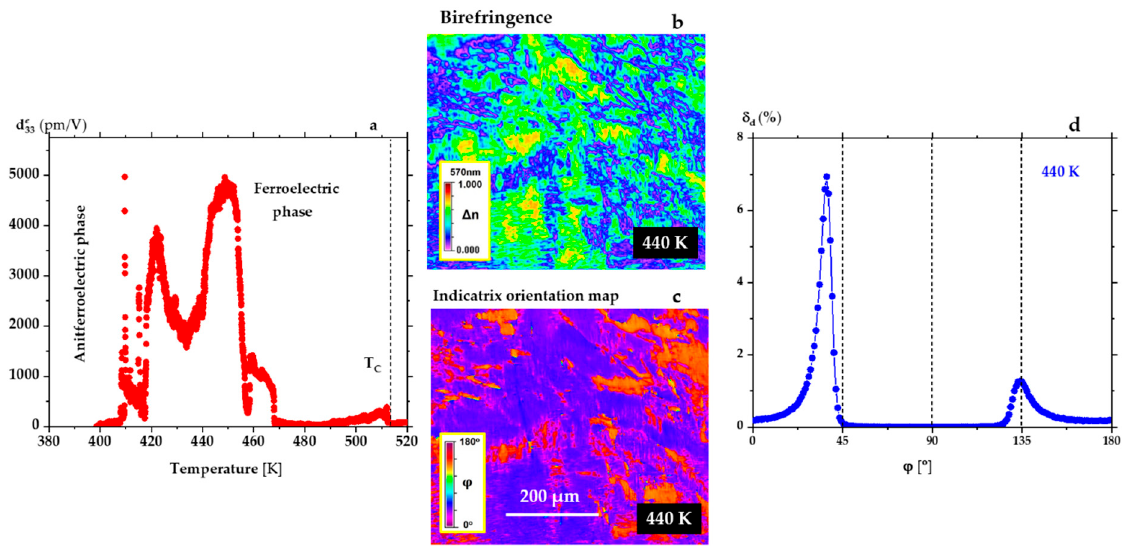
Figure 4. ( a ) Giant piezoelectric effect recorded on heating, in the temperature range between the AFE-FE and FE-P phase transitions in a PbZr 0.95 ± 0.01 Ti 0.05 ∓ 0.01 O 3 single crystal (green curve in